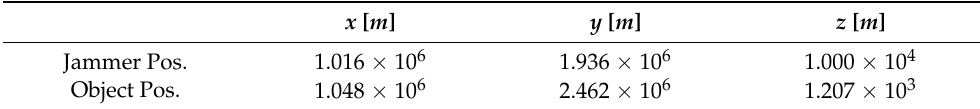
Table 1. Coordination of jammer and object.